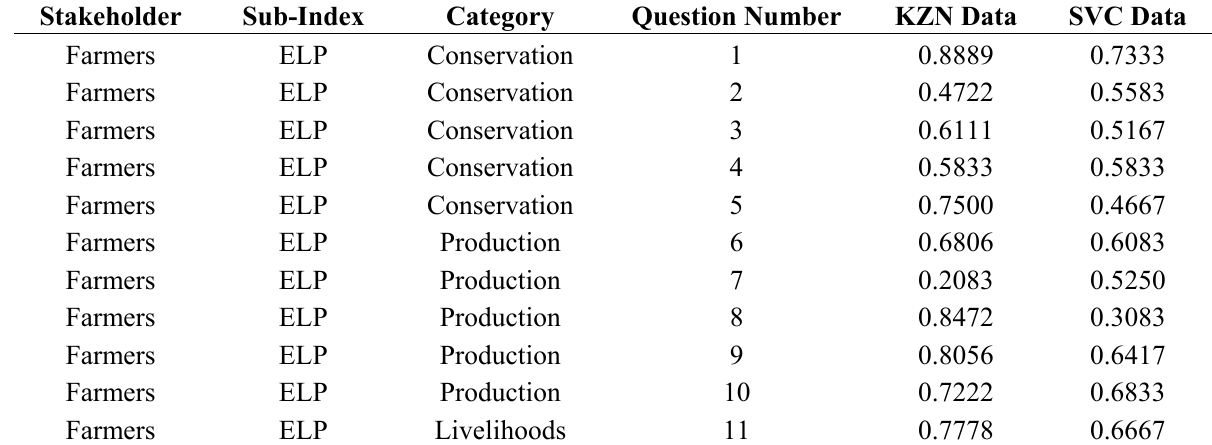
Table A1. Scores by Question. Question numbers refer to Tables 1 and